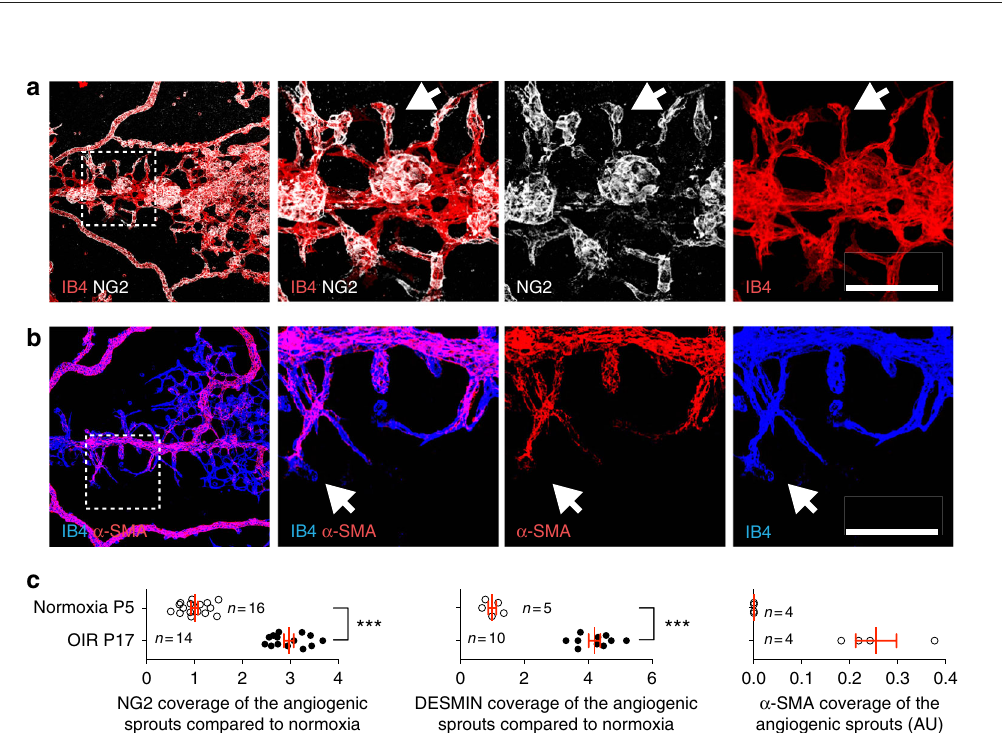
Fig. 1 Abnormal mural cells cover NVTs in the OIR retina. a Schematic of the OIR model. b qPCR analysis of Vegf-a and Pdgf-b expression in P17 OIR retinas compared to P17 retinas in normoxia ( n = 5 mice). Error bars: s.e.m. ⋆⋆⋆ P < 0.001, two-way ANOVA Sidak ’ s multiple comparisons test. c IB4 (i) and PDGF- B (ii) double staining of retina from P17 OIR mice and magni fi ed area (iii) of boxed area in ii. d IB4, NG2, and PDGFR β triple staining shows tufts expressing pericyte markers (white arrows) in P17 OIR retinas. e IB4, α -SMA, and MYH11 triple staining of P17 OIR retinas. Tufts are covered with MYH11 − SMA + cells (arrows). Note that arterioles surrounding the NVTs are covered with MYH11 + SMA + cells (arrowhead). (Bottom) Higher magni fi cations of tufts, note labeling with α -SMA but not MYH11. f Quanti fi cation of tufts labeled with the indicated markers in P17 OIR retinas ( n = 5 mice, error bars: s.e.m.). g qPCR analysis of Acta2 (encoding α -SMA) and Myh11 expression in P17 OIR retinas compared to P17 retinas in normoxia ( n = 5 mice). Error bars: s.e.m. ⋆⋆⋆ P < 0.001, ⋆⋆ P < 0.01, two-way ANOVA Sidak ’ s multiple comparisons test. h Top, IB4, α -SMA, and PDGFR β triple staining of vascular tufts from P17 OIR retinas. (Bottom) Higher magni fi cation of the boxed areas. i IB4 and FIBRINOGEN double staining of vascular tufts from P17 retinas in OIR. The dotted line marks the tufts. Scale bars, 100 μ m ( c – e top, i ) and 30 μ m ( e bottom, h